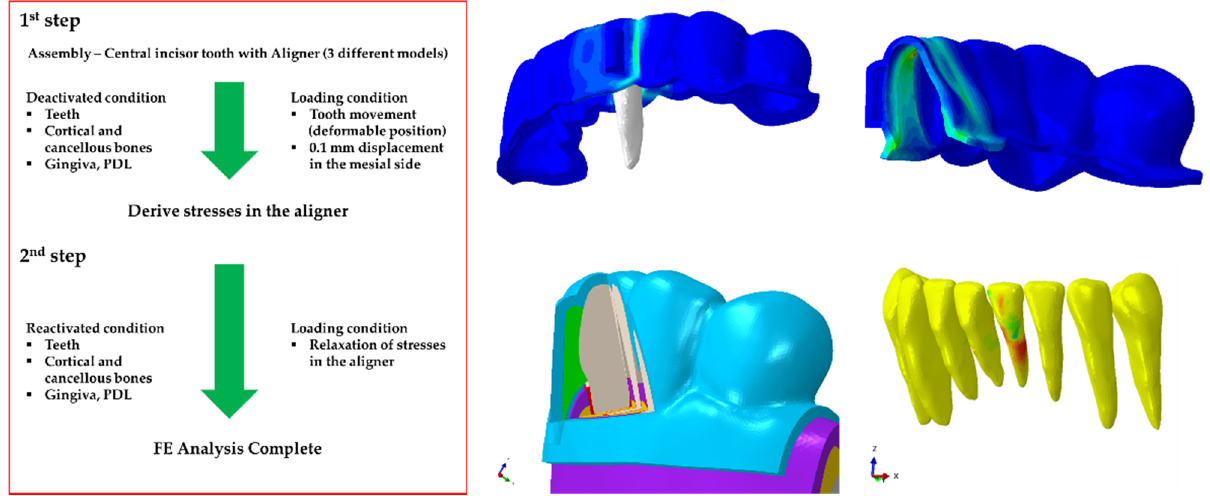
Figure 3. FE analysis process of three different orthodontic treatment models (NA, GA, OA).